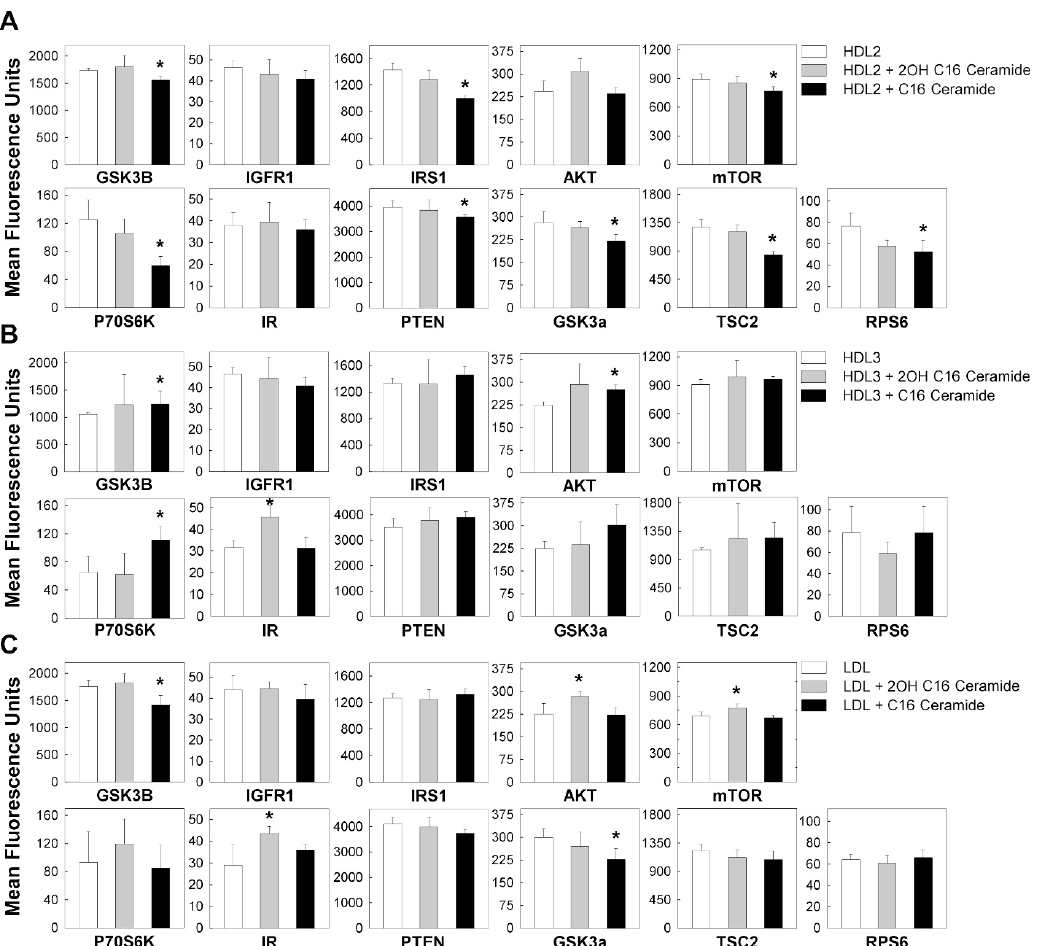
Figure 9. The mTOR signaling pathway phosphorylated proteins regulated in response to C16 ceramide- or 2OH C16 ceramide-enriched lipoproteins in human podocytes. Podocytes were induced with 200 µg/mL ceramide-enriched or with corresponding native lipoproteins (HDL2, HDL3, or LDL), and incubated for 2 h at 37 °C, 5% CO2. Cells were extracted and processed using the mTOR signaling Millipex kit (Millipore). A total of 11.5 µg protein in 25 µL assay buffer was used for each assay sample. The assay was analyzed using the Bio-Plex 200 Multiplex System (Bio-Rad). All treatments were performed in duplicates and the cell extract from each treatment was analyzed in duplicates. ( A ) Treatment with C16 ceramide-enriched HDL2, ( B ) treatment with C16 ceramide-enriched HDL3, ( C ) treatment with C16 ceramide-enriched LDL. Results from treatments with ceramide-enriched lipoproteins were compared to those with corresponding native lipoproteins using Student t -test at p ≤ 0.05.